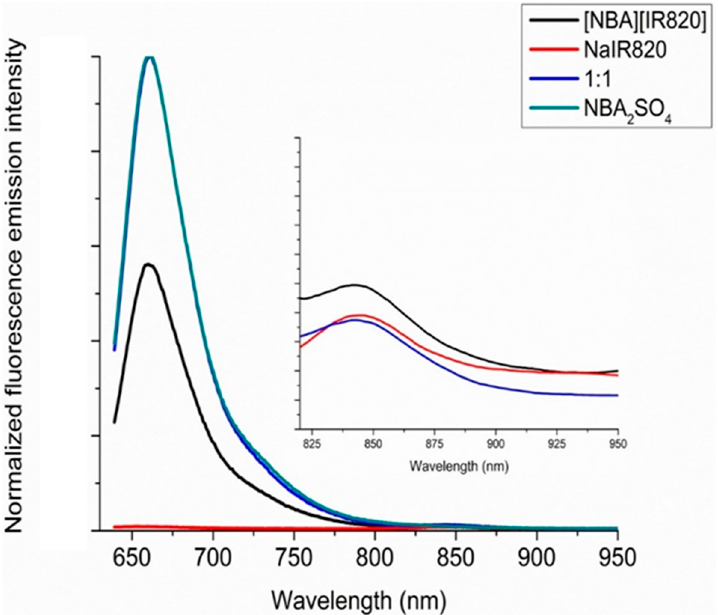
Figure 3. Normalized (with respect to parent NBA 2 SO 4 at 664 nm) fluorescence emission spectra of NaIR820, NBA 2 SO 4 , the mixture consisting of 0.5 NBA 2 SO 4 :1 NaIR820, and [NBA][IR820] IM at 629 nm excitation wavelength in ethanol.